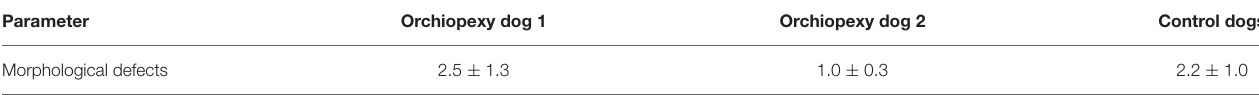
TABLE 3 | Percentage of morphological defects in orchiopexy and control dogs.